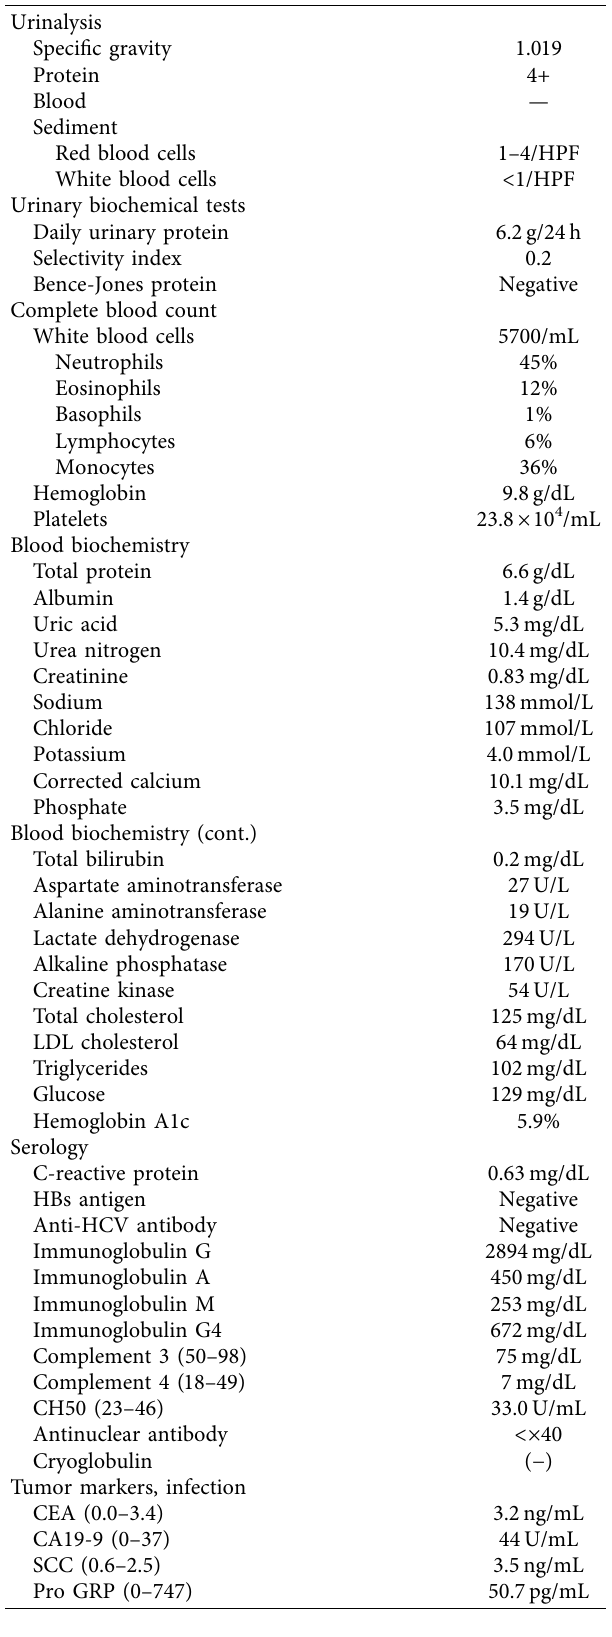
Table 1: Laboratory fndings on